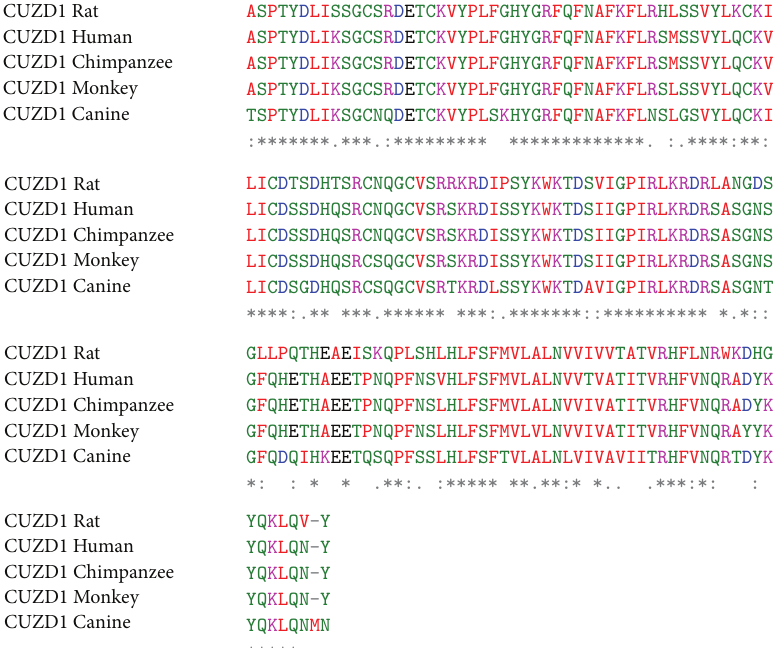
Figure 3: Multiple amino acid sequence alignment of CUZD1 of various species shows striking conservation. Sequences aligned include Rattus norvegicus (EDM 11686.1), Homo sapiens (NP 071317.2), Pan troglodytes (XP 001160209.2), Macaca fascicularis (EHH 65083.1), and Canis lupus familiaris (XP 544054.2). Asterisk indicates identities and semicolon indicates conserved or semiconserved substitutions. The alignment has been performed using the CLUSTAL W (1.83) multiple sequence alignment